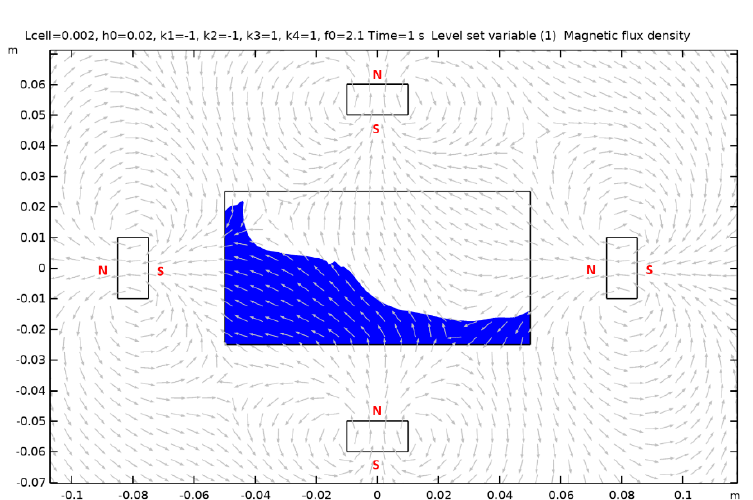
Figure A3. Case 4. Figure A3. Case 4.